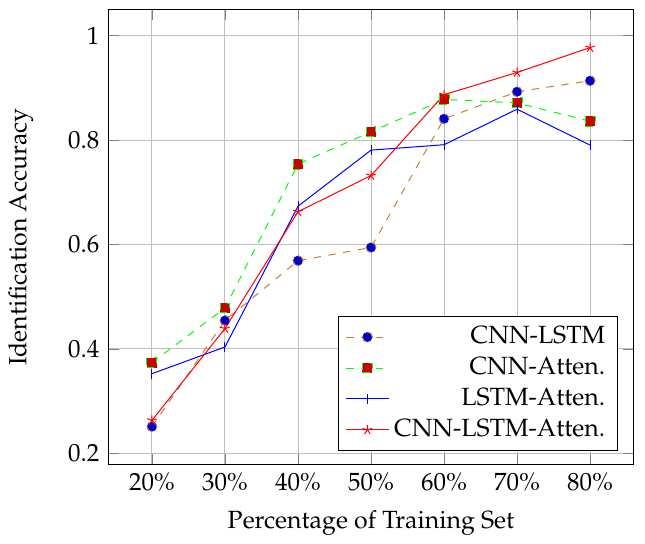
Figure 5. Identification rate in terms of the usage percentage of the training set.